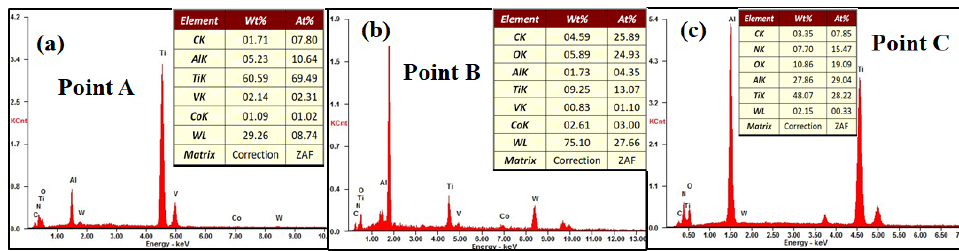
Figure 9. The EDS results of TiAlN-coated cemented carbides after TC4 turning: ( a ) Point A, ( b ) Point B and ( c ) Point C.